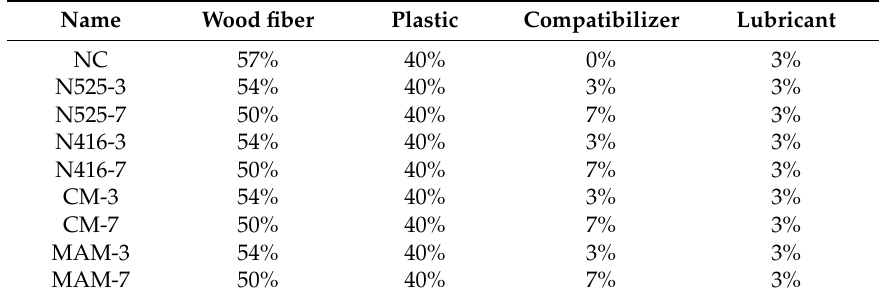
Table 9. Test materials and their naming. The components are presented by percentage of